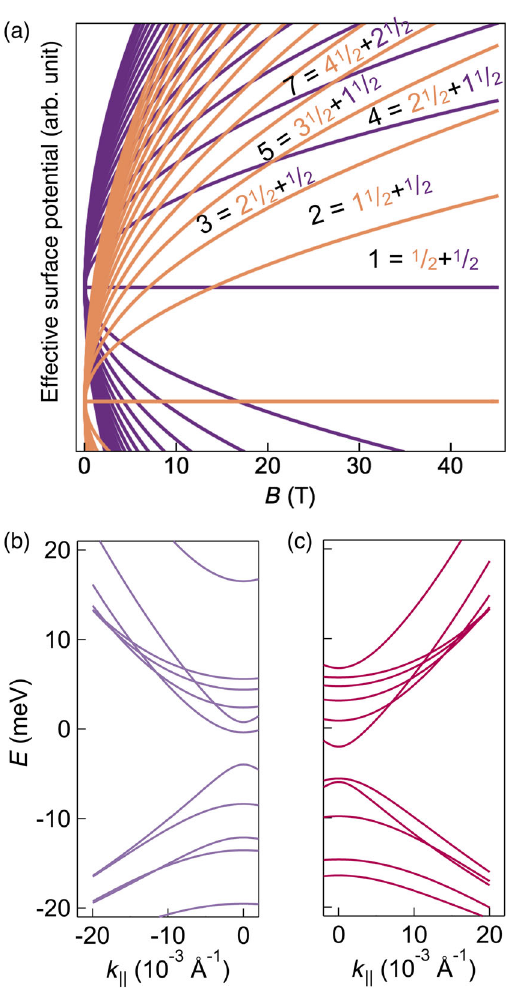
FIG. 4. (a)SchematicofLandaulevelsformedbytwotopological- insulator-like surface states, with filling factors labeled. The energy for two sets of Landau levels is plotted, with the energy of the set originating from the bottom surface scaled relative to the set originating from the top to account for the screening of the gate potential by the top surface. (b) Quantum well subbands formed in a 45-nm-thick Cd 3 As 2 film in a simple particle-in- a-box picture. (c) Quantum well subbands formed in a 50-nm- thick film. For details of the calculations, see Supplemental Material